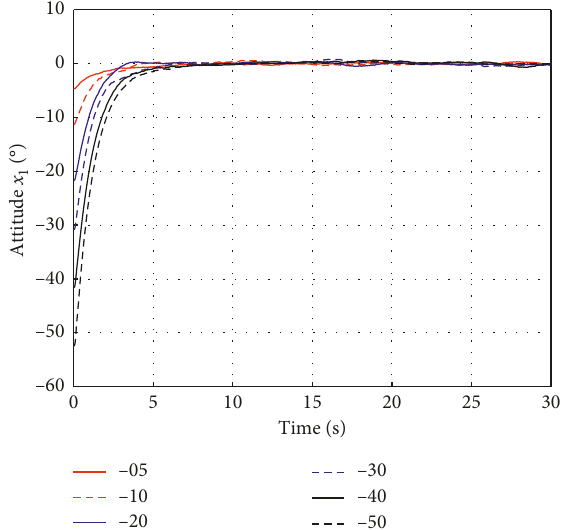
Figure 8: Time response of the angular velocity x value ( ii ) .